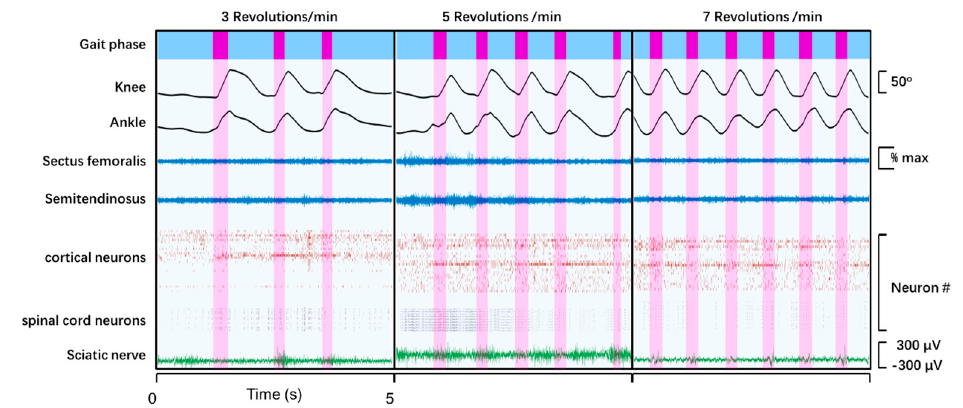
Figure 5. Application of multisite recording for the study of neural network and locomotion kinematics during forced movement in running wheel. Data from the multisite recording system for an animal (rat #4) walking in the running wheel at three different speeds: 3, 5, and 7 revolutions/min (rpm). From top: gait phase, joint angle plots at the knee and ankle, EMG signals from two muscles, raster plots of sorted cortical and spinal units, and the sciatic nerve signal during walking.